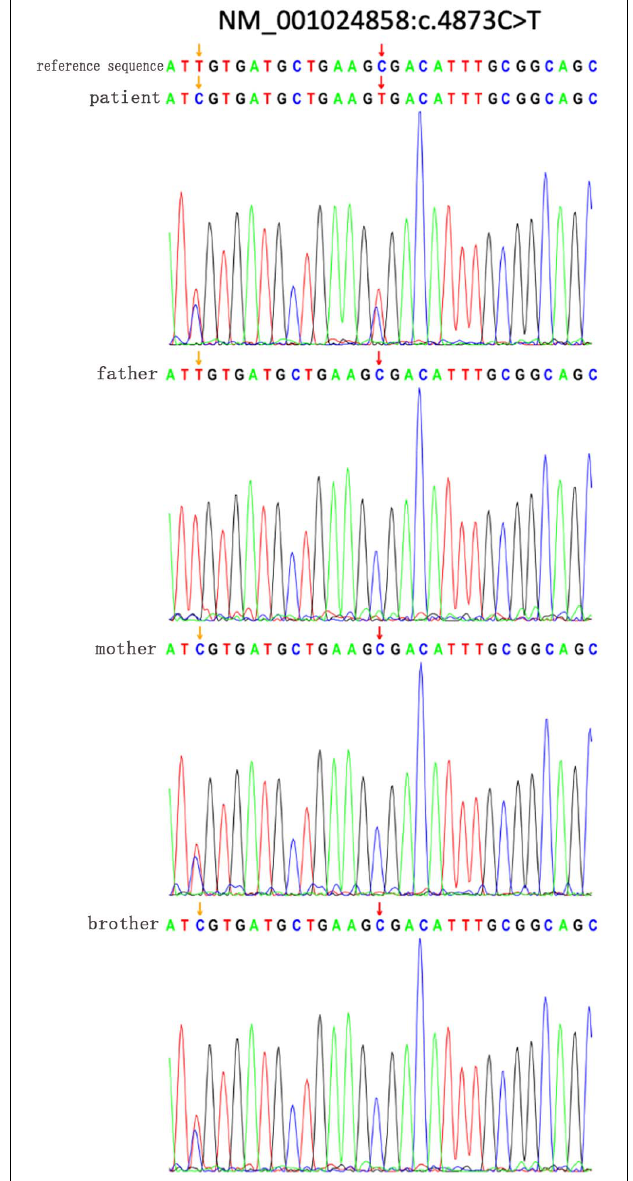
FIGURE 1 | Sanger verified that the SPTB gene c.4873C > T mutation in the family of patient 1; the yellow arrow on the left indicates that the mutation c.4860T > C was inherited from a normal mother, which is of unknown significance, and its normal brother also carries it The mutation is excluded from its pathogenicity. The red arrow on the right indicates that a new heterozygous SPTB variant mutation (C. 4873C > T, 137 p.R1625X,704).